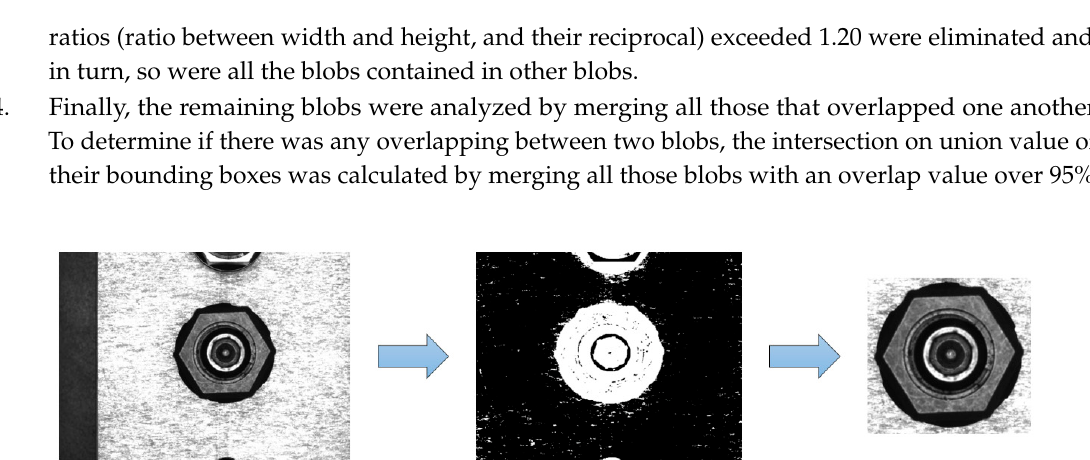
Figure 3. Pre-processing for patch extraction purposes.